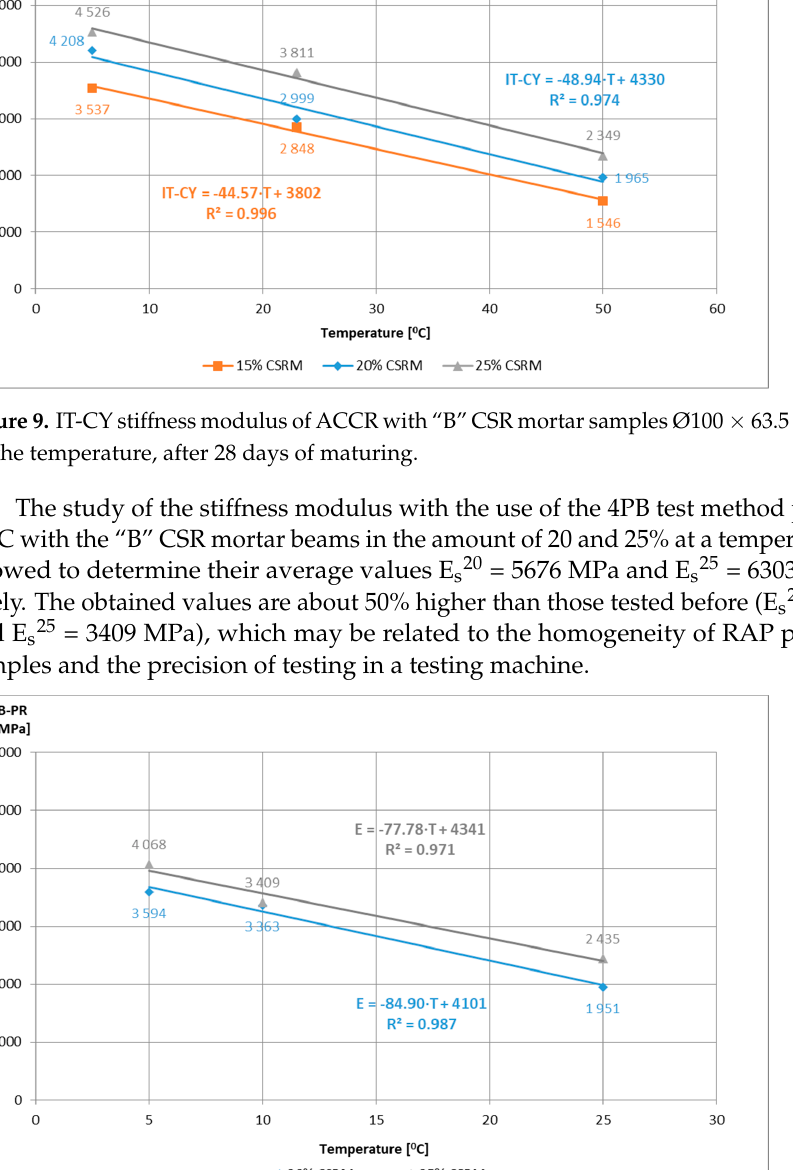
Figure 10. 4BP-PR stiffness modulus of ACCR with “B” CSR mortar beams 380 mm × 63 mm × 50 mm depending on the temperature, after 28 days of